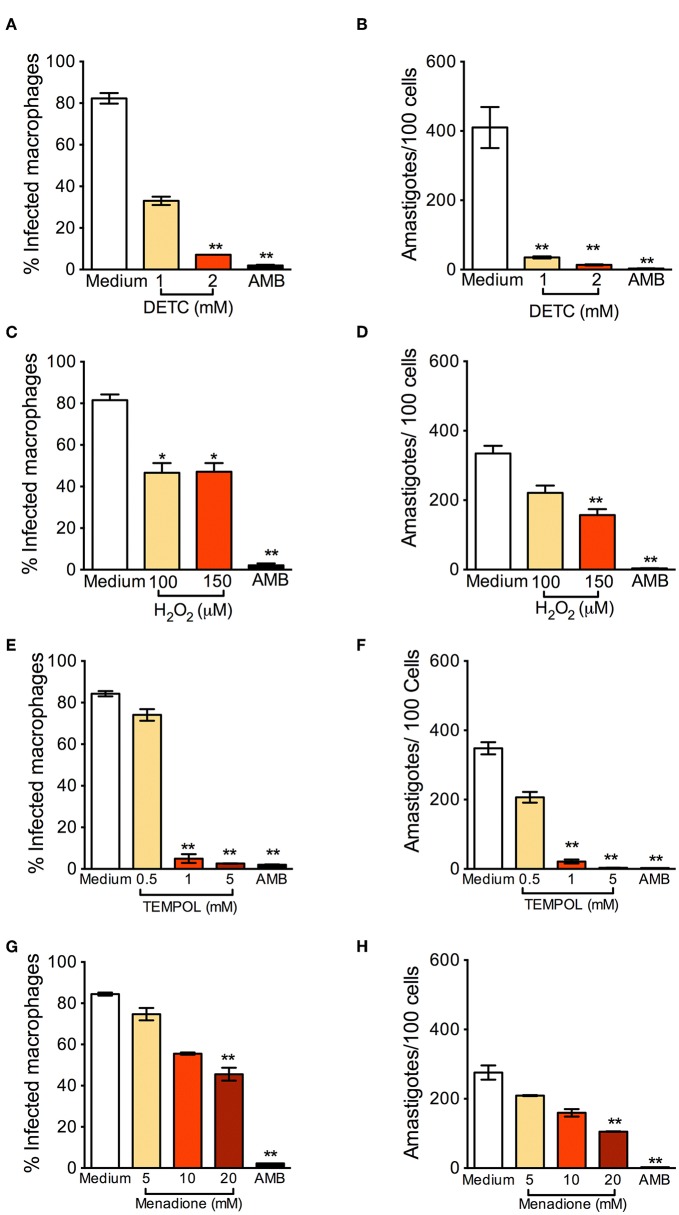
Oxidants reduce Leishmania braziliensis infection in vitro. Macrophages were infected with L. braziliensis for 24 h, and then exposed to different concentrations of DETC (A,B), H2O2
(C,D) for 24 h, Tempol (E,F), and Menadione (G,H) for 24 h. Cells were stained with H&E and assessed for the percentage of infection (A,C,E,F) and the number of amastigotes per 100 macrophages (B,D,G,H) by optical microscopy. Infected macrophages treated with Amphotericin B (AMB) were used as positive controls. Data are shown as mean ± SEM. *p < 0.05; **p < 0.01, ***p < 0.001, all comparisons were against negative control (medium).